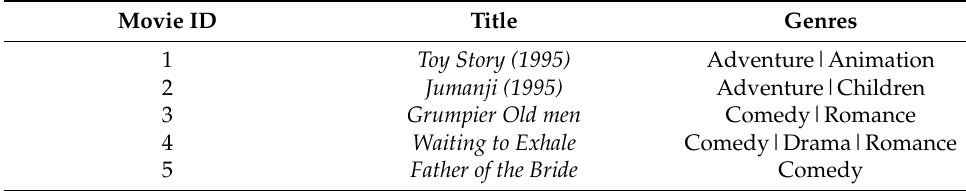
Table 2. Movie lists according to different